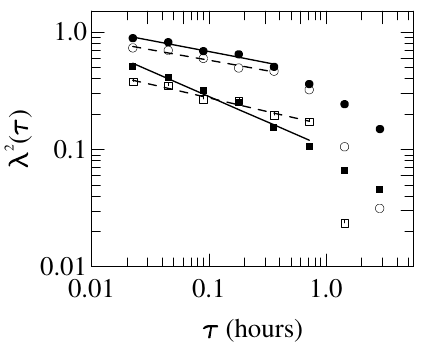
Figure 95: Scaling laws of the parameter 𝜆 2 ( 𝜏 ) as a function of the scales 𝜏 , obtained by the fits of the PDFs of both velocity and magnetic variables (see Figure 94). Solid lines represent fits made by power laws. Image reproduced by permission from Sorriso-Valvo et al. (1999), copyright by AGU.